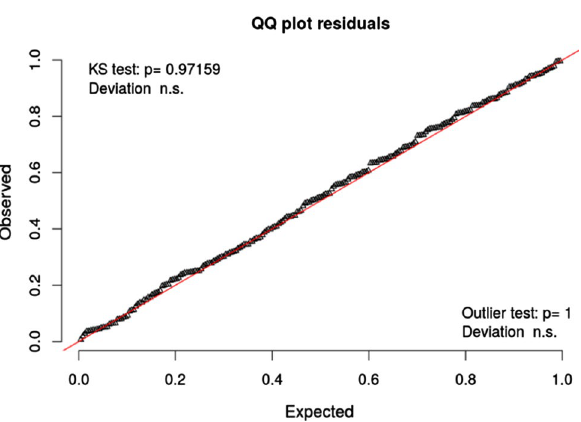
Figure 5. QQ-plot of the selected multilevel negative binomial model. n.s non-significant. The KS test indicates that the points are not far from the reference line (non-significant p -value). Similarly, the Outlier test did not reveal any significant presence of outliers in the data. It tests if the residues (expected/observed) have normal distribution and if there is any discrepant